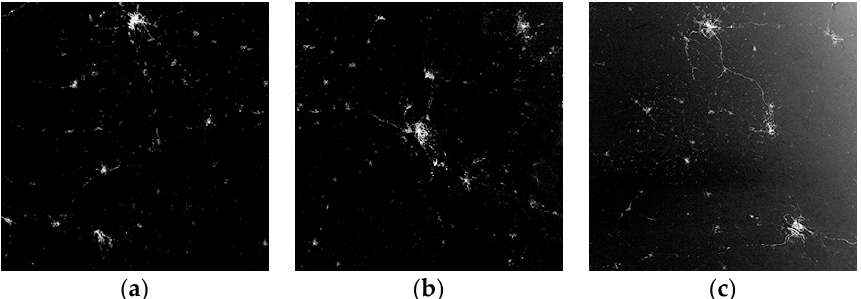
Figure 15. Different frames of nighttime image of the Moscow area (55 ° N), acquired when satellite was illuminated by sun on 21 June 2018. ( a ) Solar incident angel is 57°; ( b ) solar incident angel is 52°; ( c ) solar incident angel to optical is 47°.